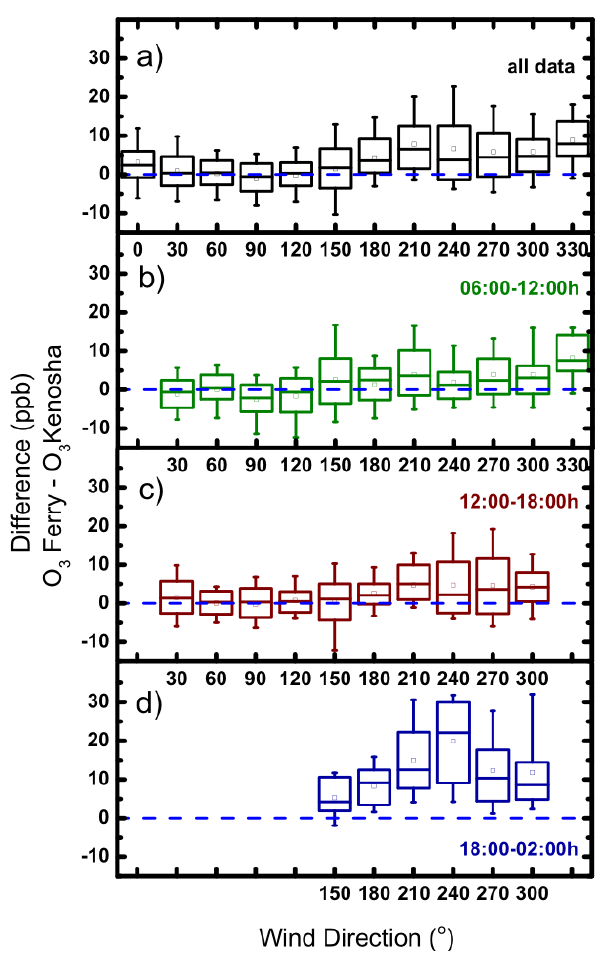
Figure 7. Difference in O 3 observations between platforms with respect to wind direction measured at Kenosha harbor for (a) all times, (b) morning (06:00–12:00CDT), (c) early afternoon (12:00– 16:00CDT) and (d) late afternoon/evening (16:00–02:00h). Box plots show mean ( (cid:3) ), median (centerline), 25–75% (box) and 10– 90% (whiskers). Each box represents a minimum of 15 points.